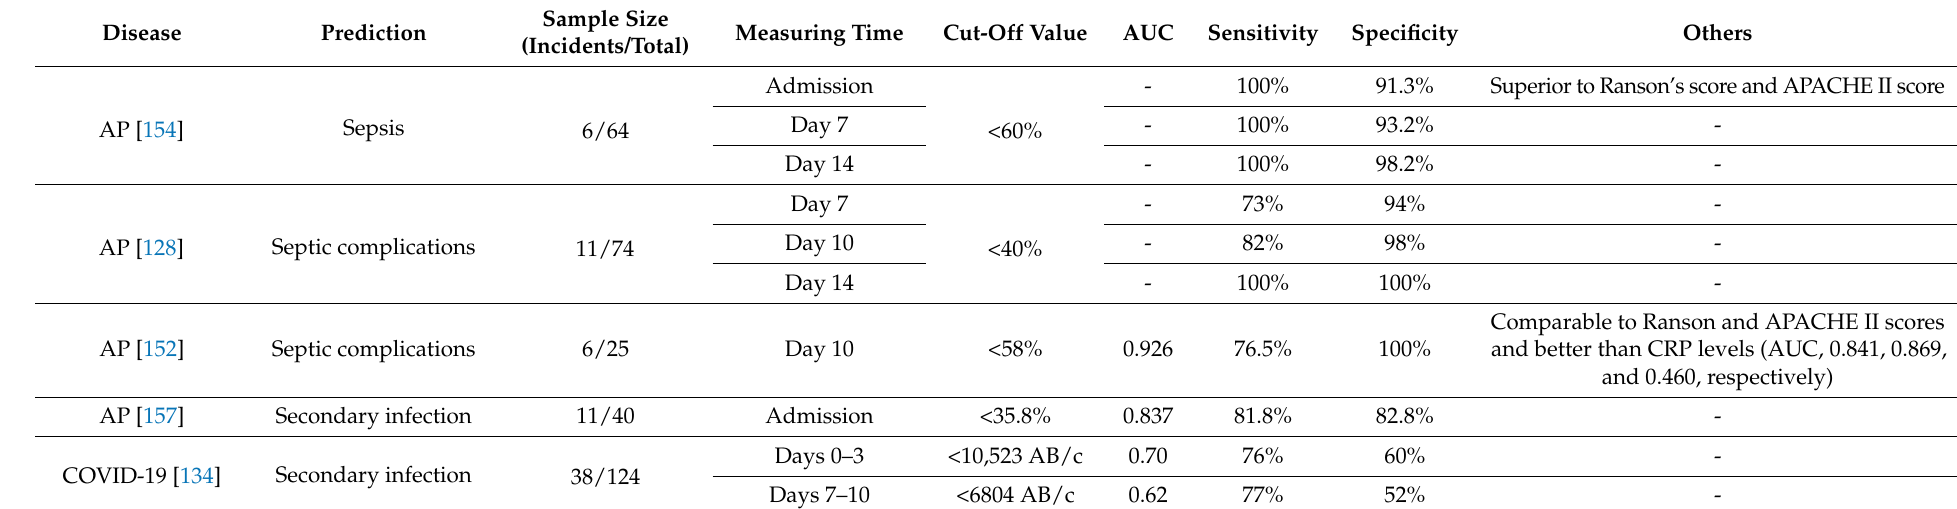
Table 3. Predictive values of mHLA-DR for septic complications in AP and